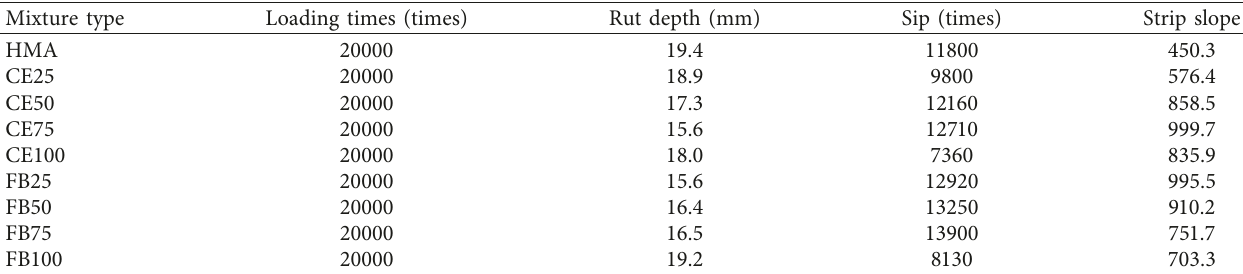
Figure 10: Results of the freeze-thaw splitting test. (a) CE type. (b) FB type. Table 8: Results of